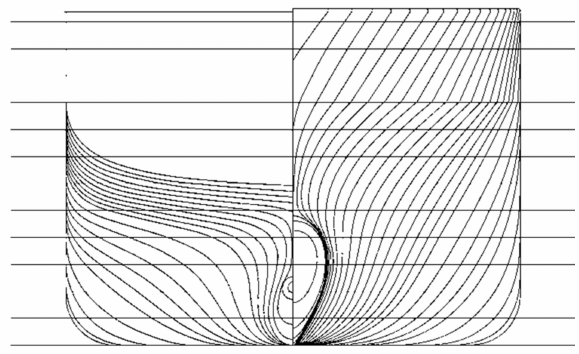
Figure 1. The body plan of